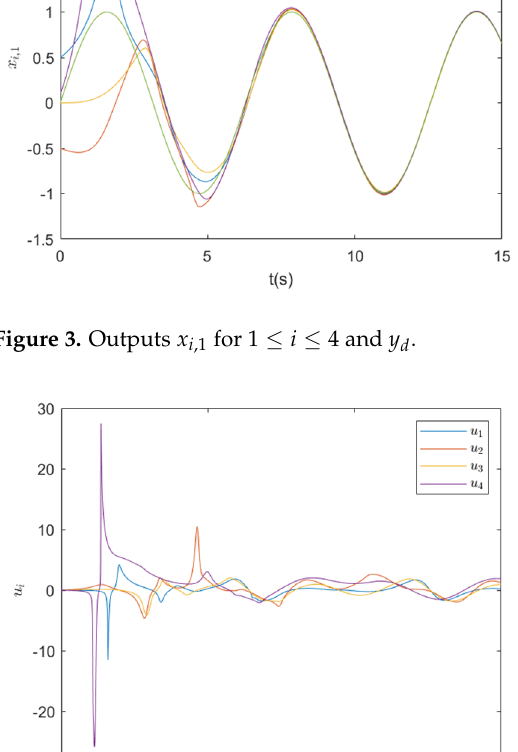
Figure 4. Distributed control inputs i u for 1 4 i ≤ ≤ .